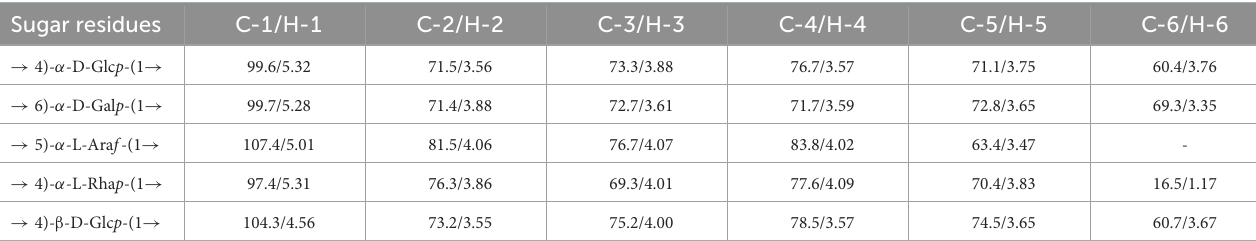
TABLE 1 1 H and 13 C NMR chemical shifts (ppm) for the polysaccharide of CP in D 2